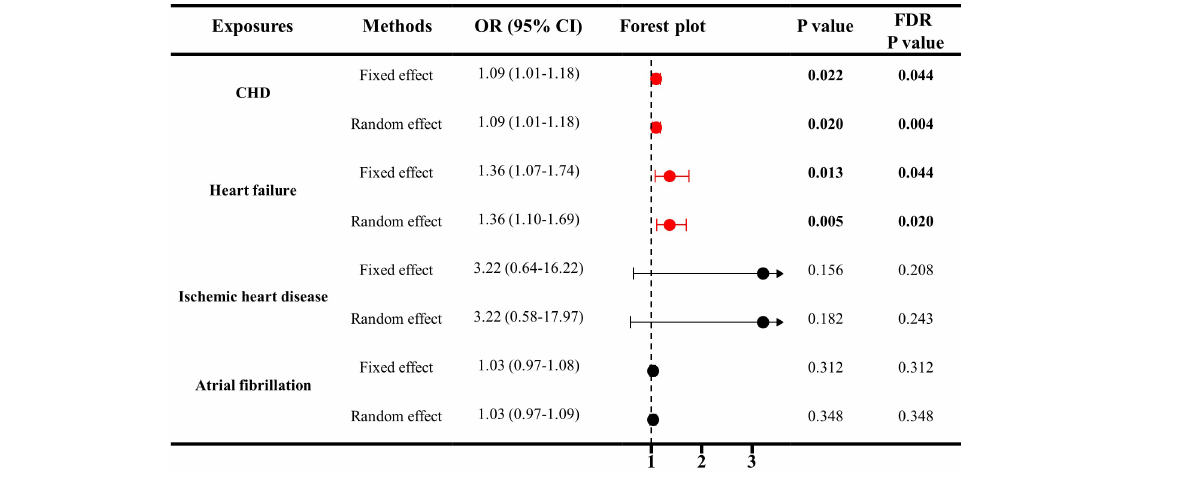
FIGURE1 The causal effects of cardiovascular diseases on ED by IVW estimator. IVW, inverse variance weighting; CHD, cardiovascular diseases; ED, erectile dysfunction; SNP, single nucleotide polymorphisms; OR, odds ratio; CI, confidence